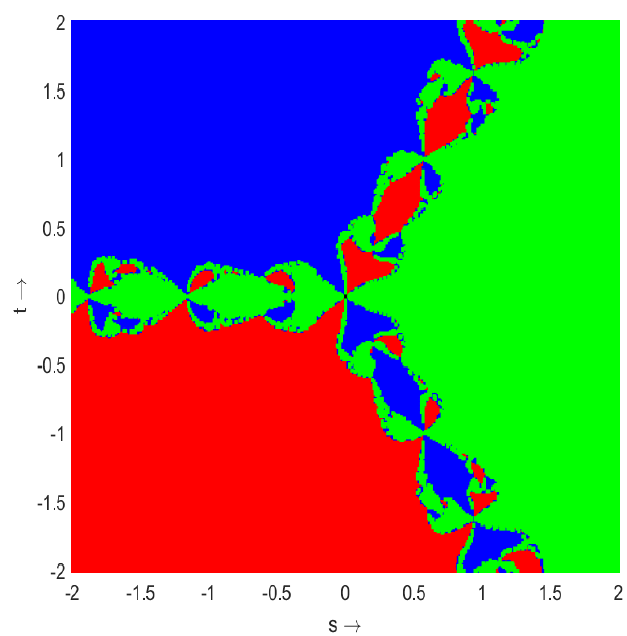
Figure 6. Dynamics of the method (4) associated with BA of Example 5. In Figure 7 (corresponding to Example 6), the red region is the set of all initial points from which the iterate (2) converges to ( points from which the iterate (2) converges to ( − initial points from which the iterate (2) converges to ( the set of all initial points from which the iterate (2) converges to ( − region represents the Julia set.